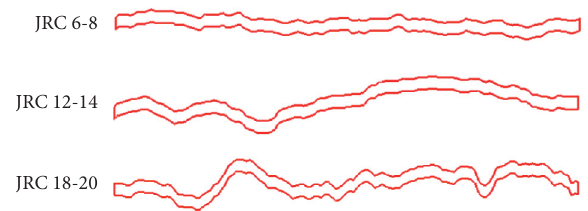
Figure 6: Schematic of discontinuities with 3 different roughness coefficients.